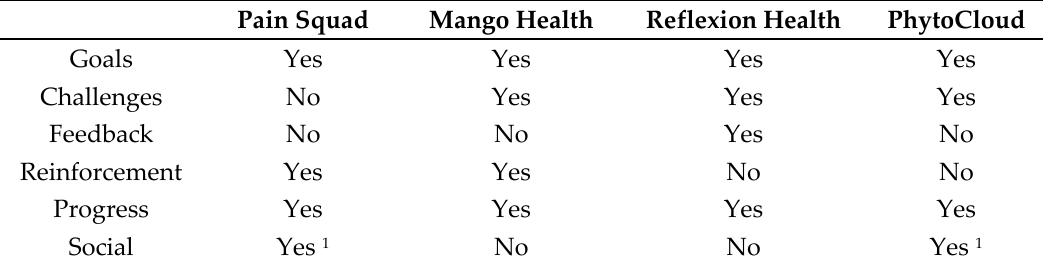
Table 1. The six mechanics of gamification compared with the applications